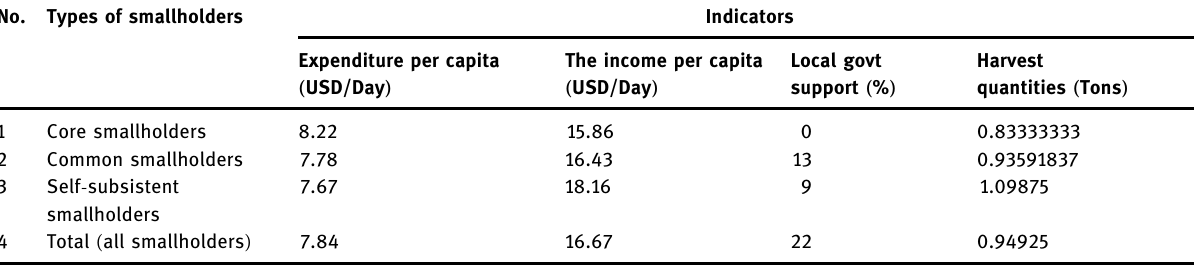
Table 1: Summary statistics of respondents